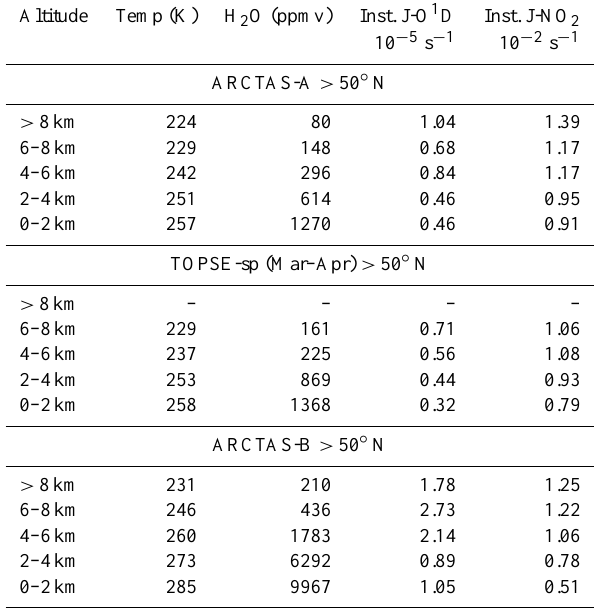
Table 3. Median meteorological conditions. Table 4. Diurnally averaged lifetimes (days) based on model calcu-